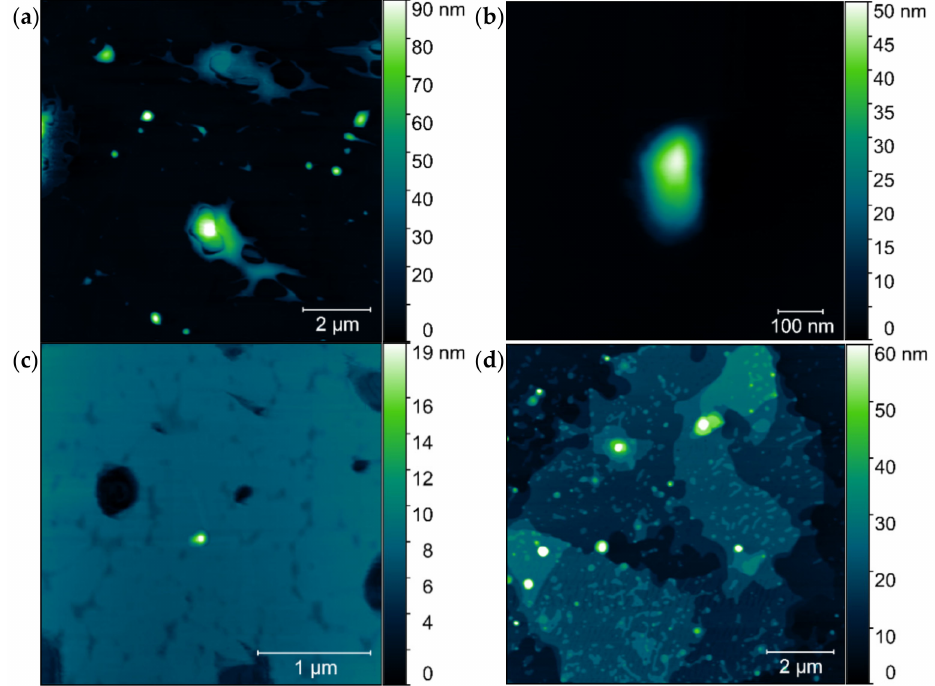
Figure 14. AFM images of the complexes based on TRI_IMI surfactant ( a , b ) TRI_IMI/DNA_20 kbp, p/n = 5; ( c ) TRI_IMI/L1/DNA_20 kbp, p/n = 5; and ( d ) TRI_IMI/L3/DNA_20 kb, p/n =